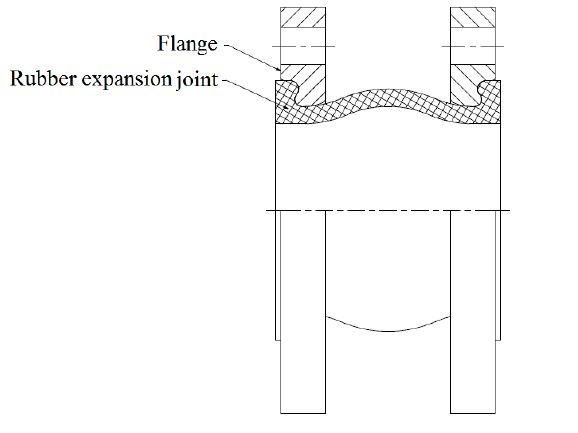
Figure 1: Rubber expansion joint with metallic loose